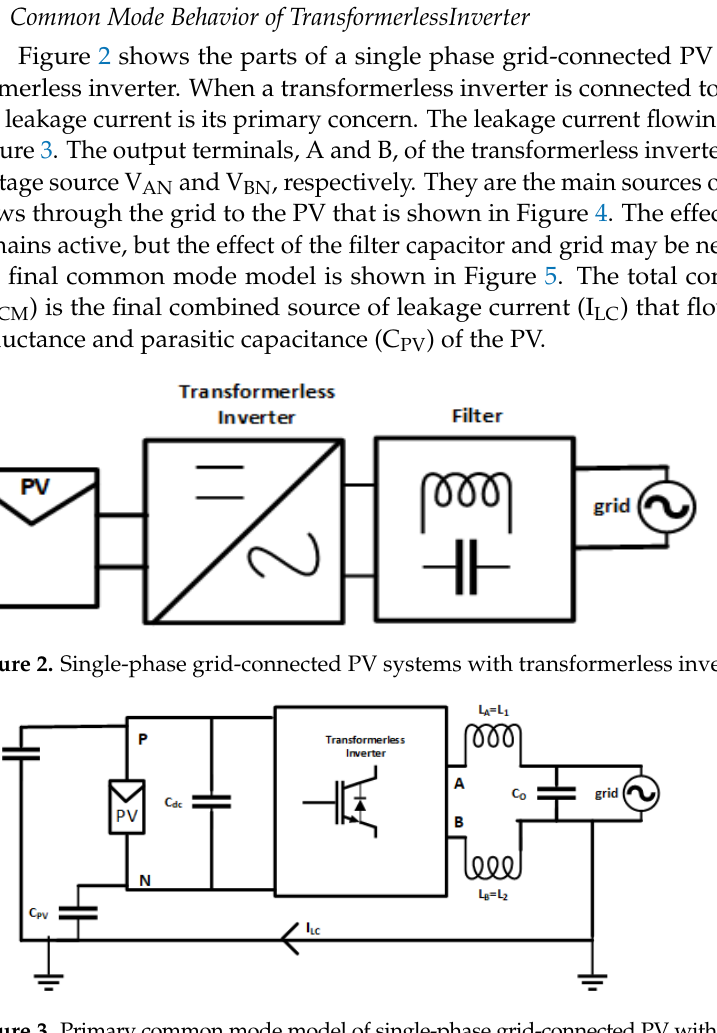
Figure 3. Primary common mode model of single-phase grid-connected PV with transformerless inverter.